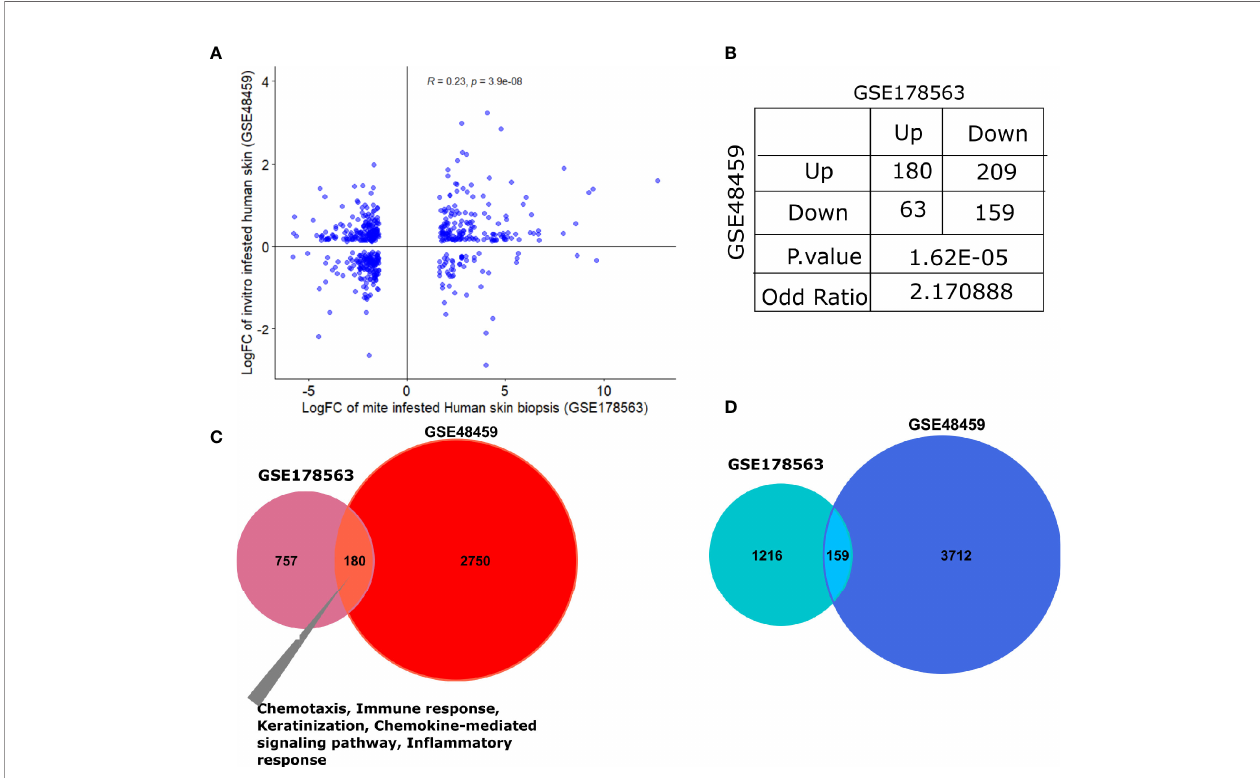
FIGURE 7 | Comparative transcriptomic analysis of GSE178563 (mite-infested human skin biopsies) with GSE48459 (live-mite-infested human skin equivalent group). (A, B) Correlation plot of logFC pro fi les and association statistics (contingency table and fi sher ’ s exact test) of signi fi cantly differentially expressed genes in mite-infested human skin biopsies and in-vitro human skin equivalents. (C, D) Venn diagram of common signi fi cantly upregulated and downregulated genes. Signi fi cantly enriched pathways in the shared pro fi les are